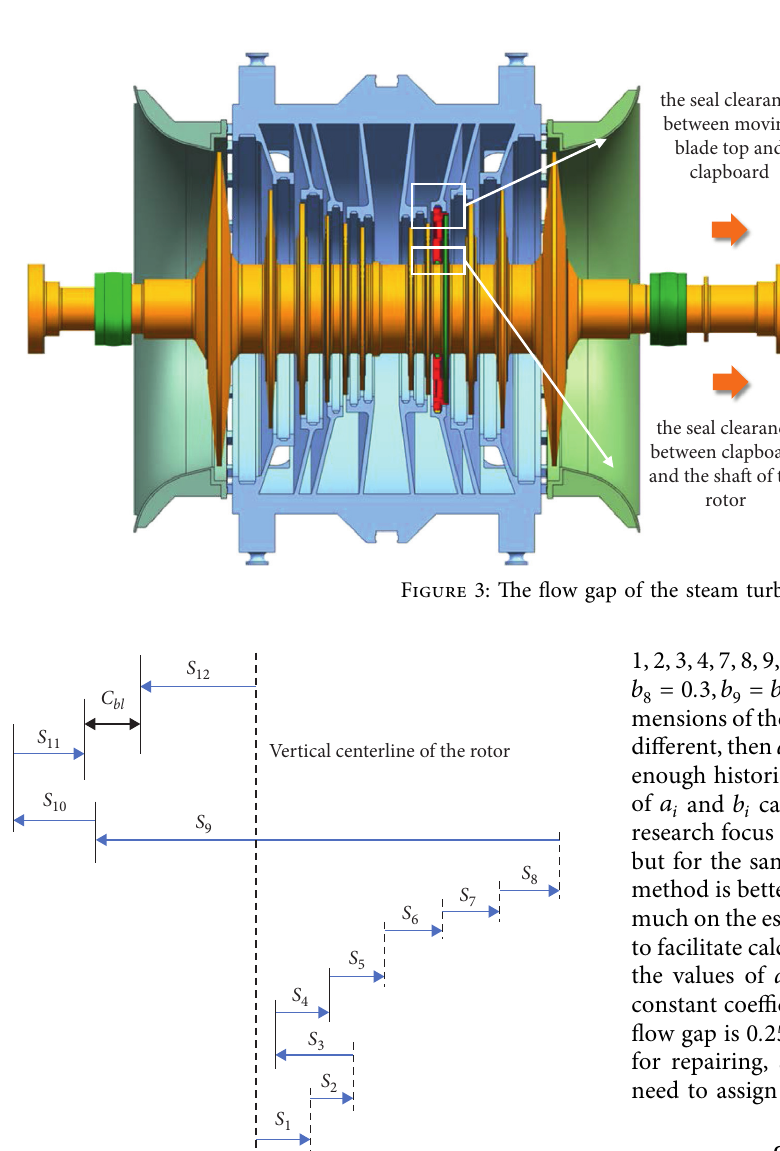
Figure 4: The plane dimension chain of the flow gap of the horizontally divided surface of the steam